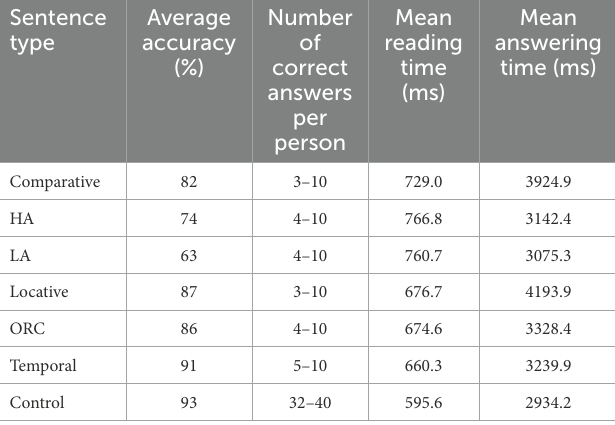
TABLE 3 Average word-by-word reading times, question answering times and accuracy in Experiment 1. Sentence